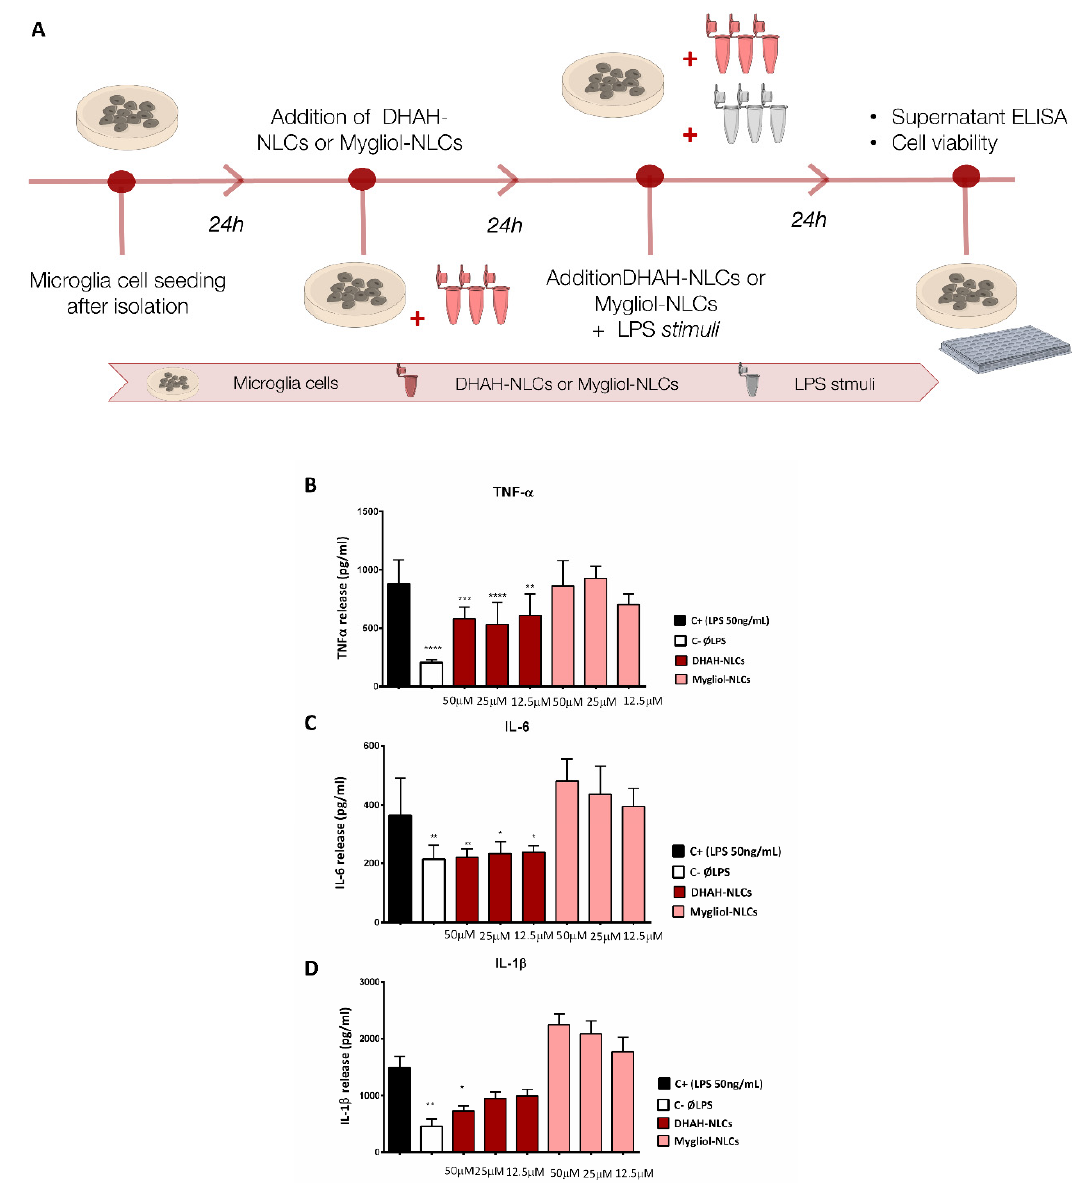
Figure 3. ( A ) Schematic representation of the antiinflammatory assay with DHAH-NLCs and Mygliol-NLCs. This figure was created using Servier Medical Art templates, which are licensed under a Creative Commons Attribution 3.0 Unported License (https: // smart.servier.com). ( B ) Graphic representation of TNF- α values (pg / mL) for all the di ff erent tested concentrations and formulations (**** p < 0.0001 C + vs. C − and 25 µ M DHAH-NLCs, *** p < 0.001 C + vs. 50 µ M DHAH-NLCs, ** p < 0.01 C + vs. 12.5 µ M DHAH-NLCs); one-way ANOVA. ( C ) Graphic representation of IL-6 values (pg / mL) for all the di ff erent tested concentrations and formulations (** p < 0.01 C + vs. C − and 50 µ M DHAH-NLCs, * p < 0.05 C + vs. 25 µ M DHAH-NLCs and 12.5 µ M DHAH-NLCs); one-way ANOVA. ( D ) Graphic representation of IL-1 β values (pg / mL) for all the di ff erent tested concentrations and formulations (** p < 0.01 C + vs. C − and * p < 0.05 C + vs. 5 µ M DHAH-NLCs); one-way ANOVA.